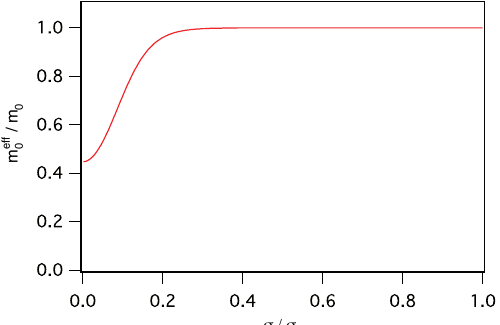
Figure 13. Effective mobility of an elementary edge dislocation crossing a forest of screw dislocations as a function of the applied stress. The mobility is normalized by the intrinsic mobility and the stress by the critical stress of the undulation instability. This curve have been plotted by taking b = 3 nm, L = 17 µ m, E kink = 3.3 k B T and E = 3 × 10 − 12 N [72] and σ c = 400 N/m 2 . These values correspond to a 100 µ m-thick sample of 8CB at 32 ◦ C when α = 5 × 10 − 4 rad. (adapted from Ref. [55], with kind permission of the European Physical Journal).